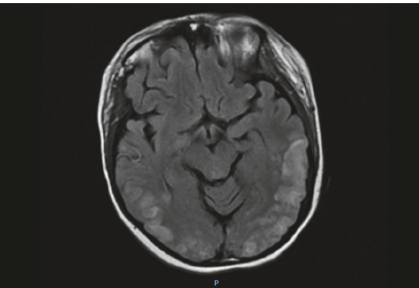
Figure 4: Brain magnetic resonance imaging (MRI) demonstrated symmetrical bilateral hyperintensities on T2-weighted imaging and fluid-attenuated inversion recovery (FLAIR) sequences consistent with cerebrocortical